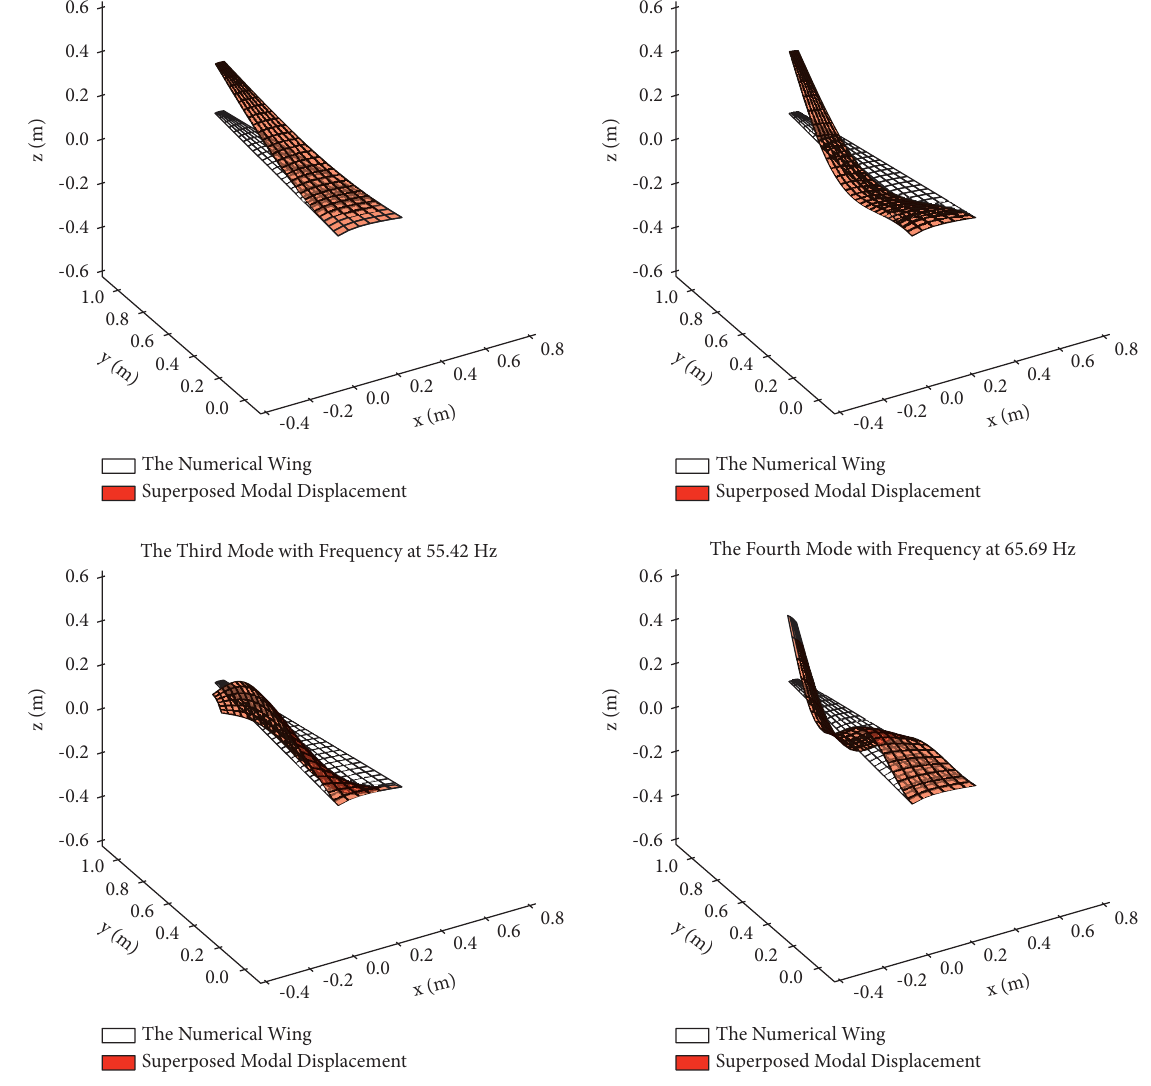
Figure 4: Vibrations and frequencies of the first four